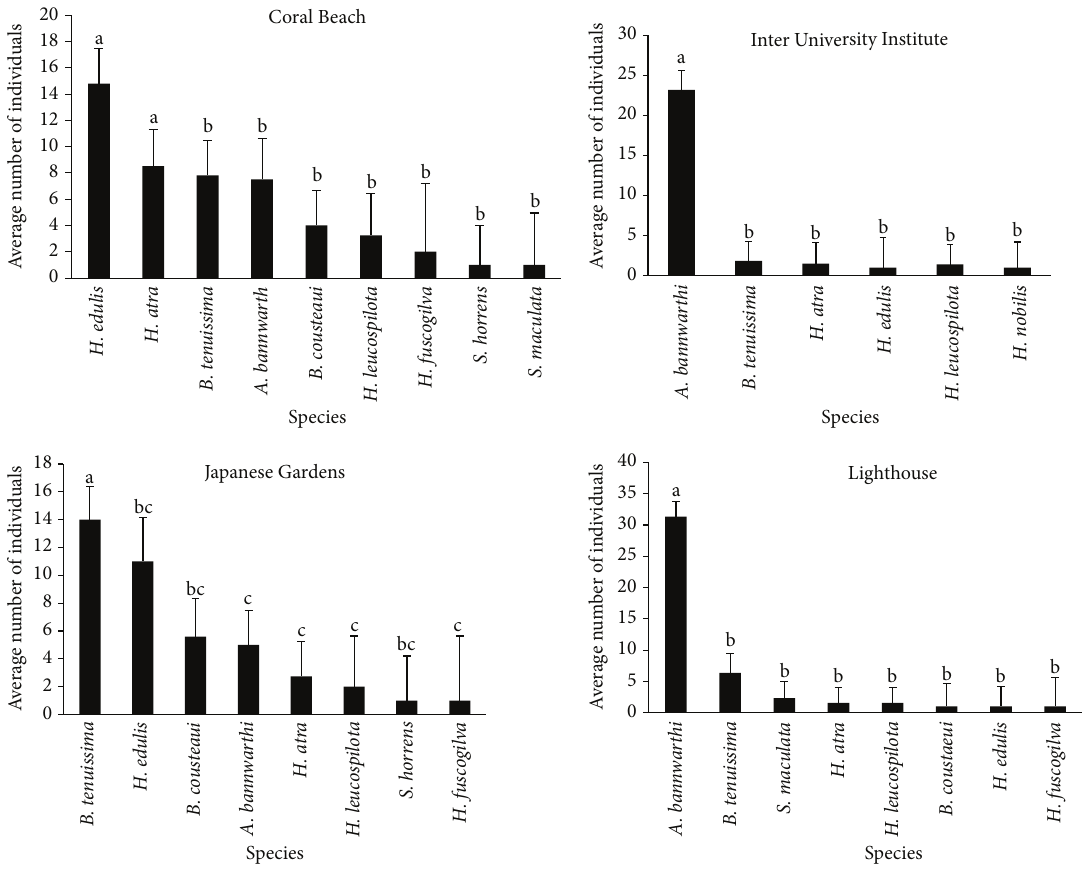
Figure 3: Abundance of holothuroids in the 4 sites sampled. Data averaged ( ± S.E.) from 5-6 replicates per site. Different letters denote significant differences in abundance between species within sites ( 𝑃 < 0.05 , ANOVA followed by post hoc Student’s 𝑡